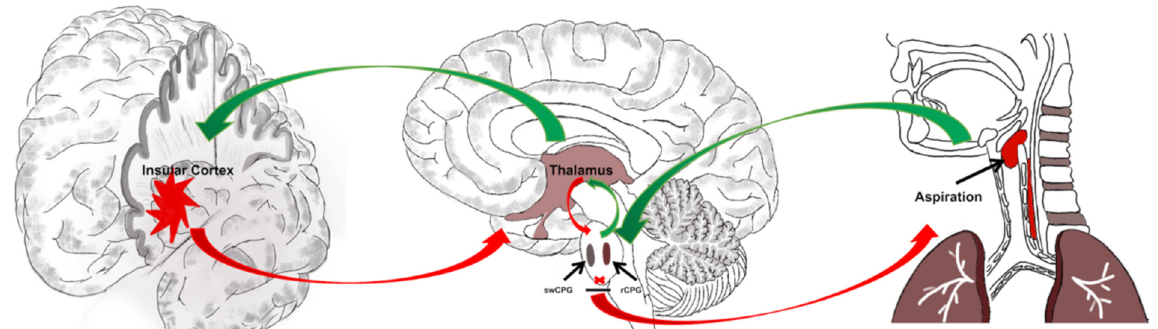
Figure 3. A hypothesis for the mechanism of the insular cortex on aspiration after PSD based on previous studies. Firstly, the brainstem receives input signals from peripheral organs (including the tongue, bronchial, and esophagus), in which the swCPG and rCPG located in the brainstem are reciprocal inhibition. Secondly, the thalamus receives input signals from the brainstem. Eventually, the insular cortex receives input signals from the thalamus. The stroke in the insular cortex may disturb the reciprocal inhibition relationship of swCPG and rCPG, which may lead to PSD and as- piration after PSD. Note: PSD, post-stroke dysphagia; swCPG, swallowing center pattern generator; rCPG, respiratory center pattern generator. Green arrow, promotion; red arrow, inhabitation.